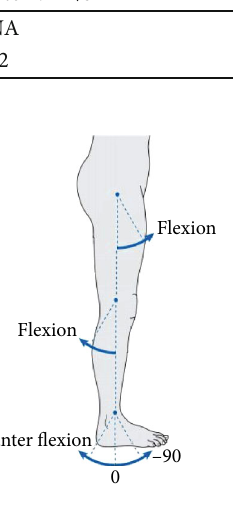
Figure 6: Angle convention for hip fl exion, knee fl exion, and ankle plantar fl exion. The vertical axis is zero degrees and the arrows show the positive direction. In the normal standing position shown, the hip angle is 0, the knee angle is 0, and the neutral ankle angle is approximately -90